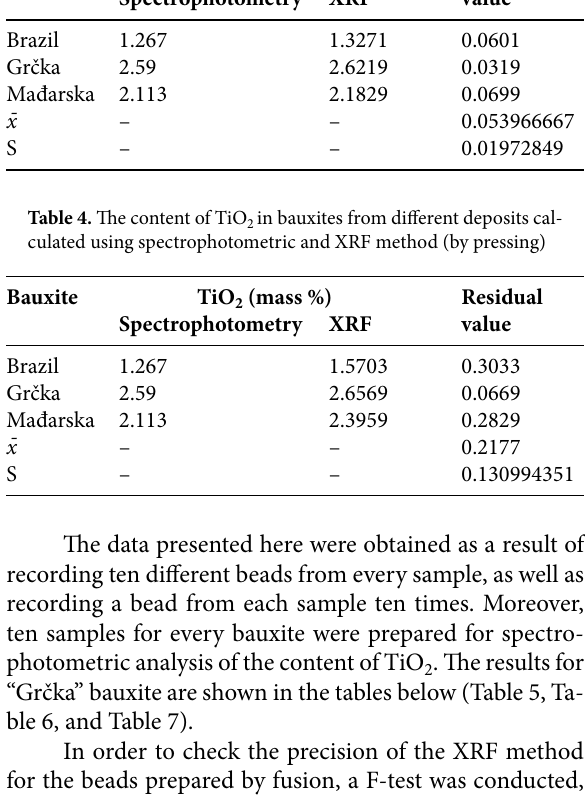
Table 3. The content of TiO 2 in bauxites from different deposits, calculated using a spectrophotometric and XRF method (by fusion) Bauxite TiO 2 (mass %) Residual